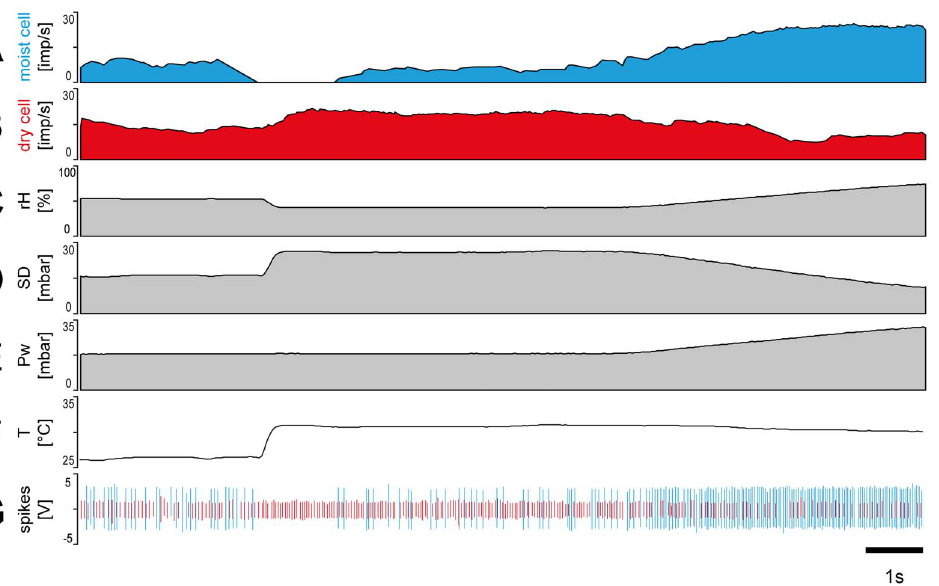
Figure 4. Simultaneously recorded responses of a pair of moist and dry cells from a single sensillum to transient and ramp-like changes in humidity. A and B. Antagonistic responses of moist and dry cells to humidity changes produced by an increase in temperature at constant water vapor pressure or an increase in water vapor pressure at constant temperature. Instantaneous impulse frequency; bin width, 1 s. C. Time course of relative humidity. Final 3 seconds of a 20 s presentation of an air stream with 49.5% rH , followed by a humidity drop to 37.5% rH which was held for 7 s; stimulus direction was then reversed by presenting a ramp-like humidity increase from 41.0% to 74.1% rH . D. Time course of saturation deficit. The drop in relative humidity shown in C is expressed as jump in saturation deficit from 15.9 mbar to 25.0 mbar, and the ramp as a slow decrease from 25.0 to 10.6 mbar. E. Time course of water vapor pressure. The humidity ramp was produced by changing the water vapor pressure slowly from 18.1 to 31.5 mbar. F. Time course of temperature. Rapid humidity change produced by a temperature drop from 26 u C to 30 u C. G. Digitized action potentials of the moist and dry cells recorded simultaneously with a single electrode and discriminated on-line. Pw water vapor pressure, rH relative humidity, SD saturation deficit, T temperature, V volt.